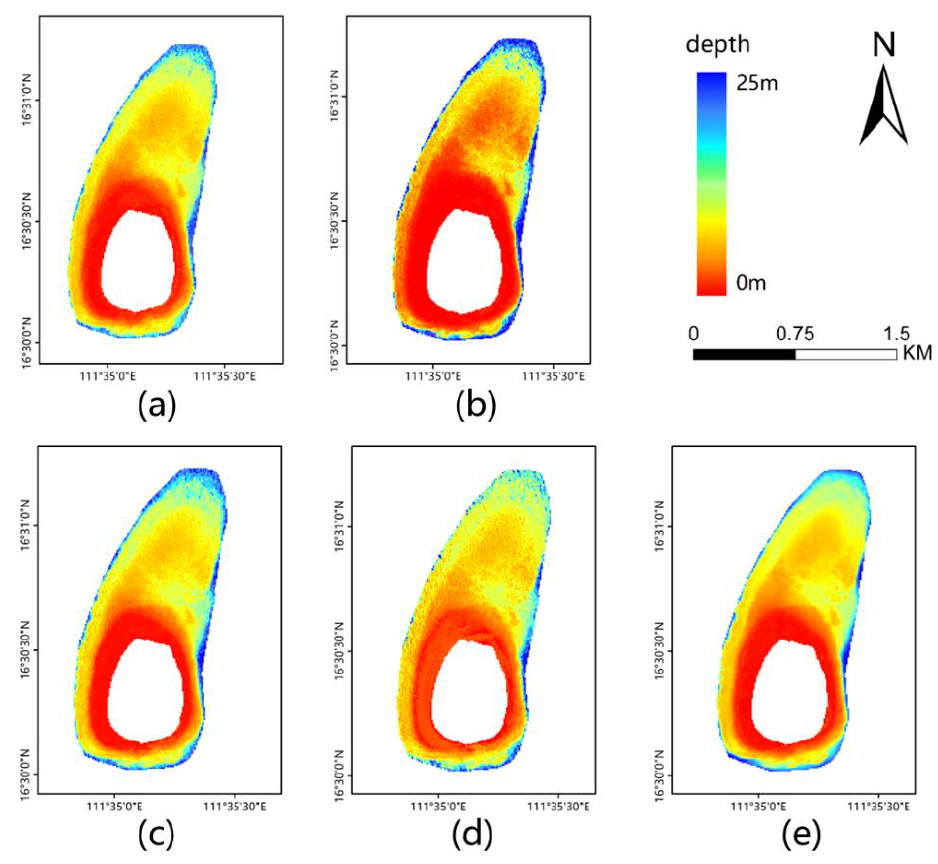
Figure 7. ( a – d ) Bathymetric inversion results of the random forest model, the neural network model, the support vector machine model, and the Stumpf model. ( e ) Actual water depth.